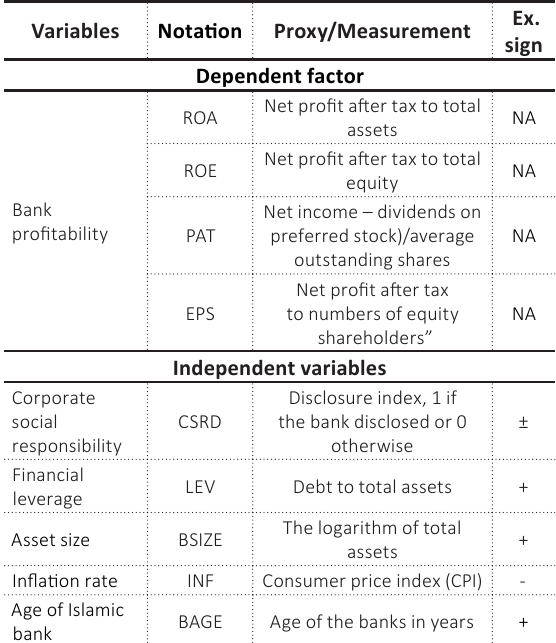
Table 2. Measurement of